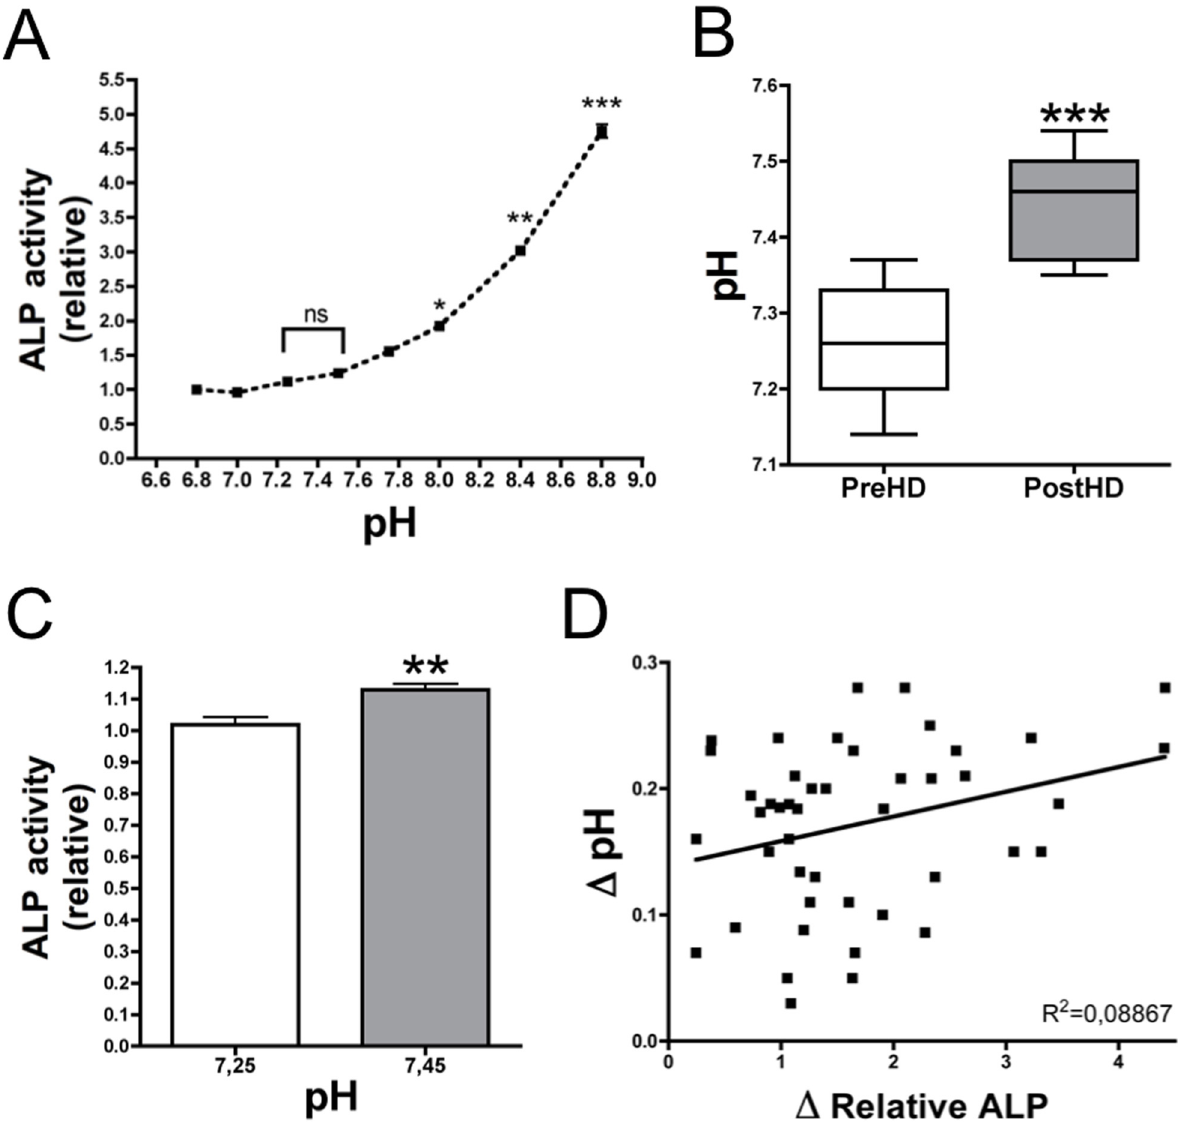
Fig 5. Influence of plasma p H on alkaline phosphatase activity. ( A ) A p H -dependent curve using ten pools comprising four different post-hemodialysis plasma samples per pool at the p H indicated. Friedman ’ s one-way ANOVA test and Dunn ’ s post-test were used for statistical analysis. ( B ) Box and whiskers graph demonstrating pre- and post-hemodialysis plasma p H values (preHD and postHD, respectively; n = 10). ( C ) ALP activity in post-hemodialysis plasmas was quantified at the p H indicated. ( B, C ) Plasma samples were collected from all patients (n = 45), and results were analyzed using the Wilcoxon matched pairs test. ( D ) The scattergraph demonstrates a correlation between Δ p H (the difference in post- and pre-hemodialysis p H ) and Δ Relative ALP (the difference in post- and pre- hemodialysis relative ALP levels). * P < 0.05; ** P < 0.01; *** P < 0.001